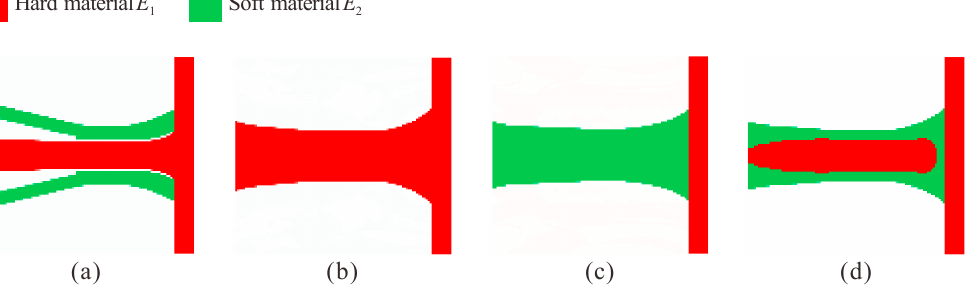
Figure 4. Topology optimization results for multi-material flexure hinge ( a ) E 1 = 71 GPa, V 1* = 0.15, E 2 = 1 GPa, V 2* = 0.15, and single-material flexure hinges; ( b ) E 1 = 71 GPa, V 1* = 0.3, E 2 = 1 GPa, V 2* = 0; ( c ) E 1 = 71 GPa, V 1* = 0, E 2 = 1 GPa, V 2* = 0.3; ( d ) E 1 = 71 GPa, V 1* = 0.15, E 2 = 71 GPa, V 2* = 0.15.